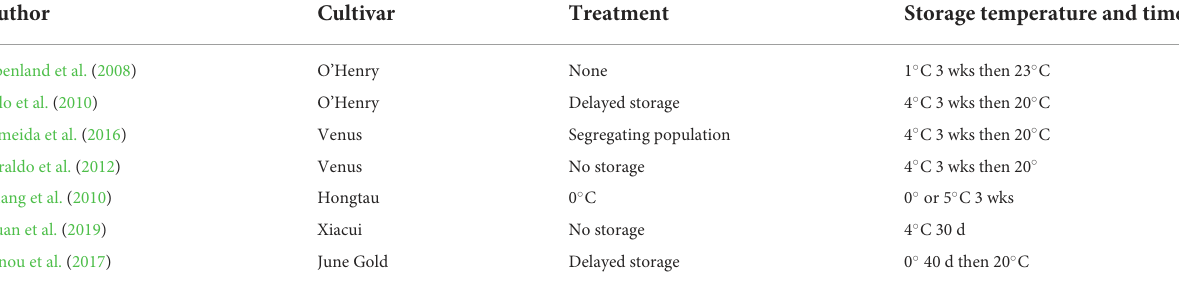
TABLE 1 Treatments used proteomic studies of peach or nectarine for prevention of chilling